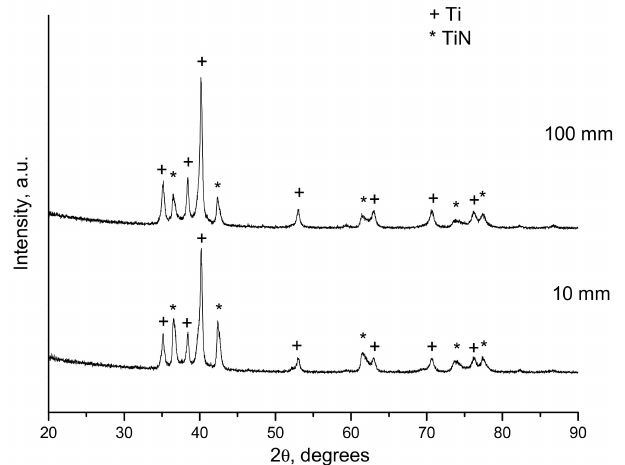
Figure 3. XRD patterns of deposits obtained by detonation spraying of titanium (carrier gas—air, explosive charge 50%, with introduction of N 2 (33 vol. %) into the oxygen-acetylene mixture, k = 1.1, spraying distances 10 mm and 100 mm). These results were obtained in a study reported in Ref.